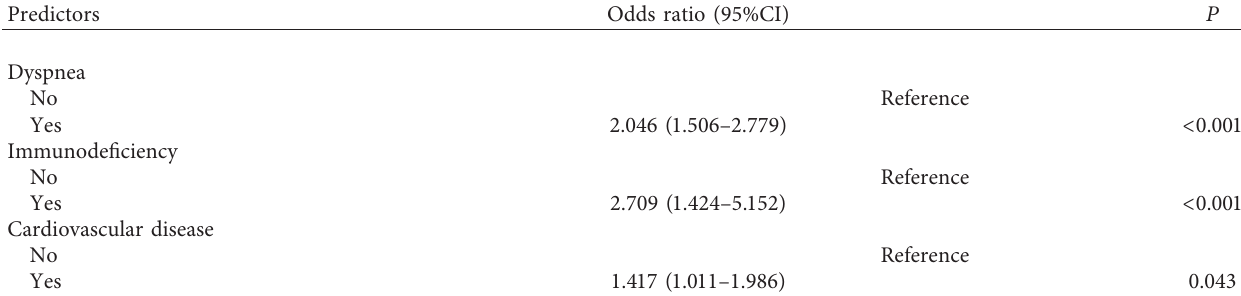
Table 4: Predictor variables of mortality in COVID-19 patients with hypertension based on the results of multiple logistic regression. Predictors Odds ratio